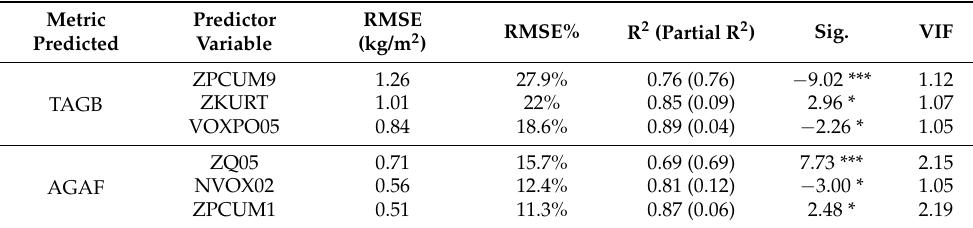
Figure 7. Plots showing the correlation between ( a ) TAGB and ZPCUM9, ( b ) the relationship between actual biomass and predictions obtained from our best model with three variables (ZPCUM9, ZKURT and VOXPO05), ( c ) the correlation between AGAF and ZQ05, and ( d ) the relationship between actual fuel load and predictions obtained from our best model with three variables (ZQ05, NVOX02 and ZPCUM1). Solid red lines represent the line of best fit for the fitted linear models, and in ( b , d ), the dashed black line represents the 1:1 line. Table 6. Statistics for the two multiple regression models. Shown are root mean square error (RMSE), relative RMSE (RMSE%), model cumulative coefficient of determination (R 2 ) and partial R 2 (i.e., gain in R 2 resulting from inclusion of the variable). For the significance category, the t values and p categories from t -tests are shown, with asterisks ***, *, respectively, representing significance at p = 0.001 and 0.05. The variance inflation factor (VIF) is also